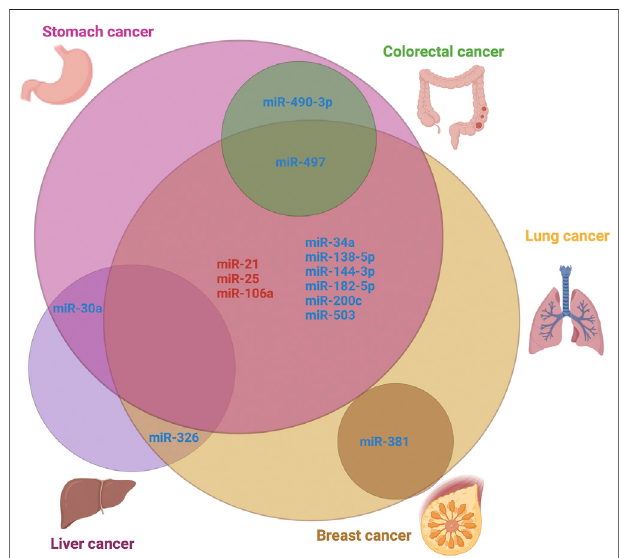
FIGURE 2 | Venn diagram showing the common microRNAs expressed in the top fi ve deadliest cancer. Upregulated microRNAs are highlighted in red color, whereas downregulated ones are in blue